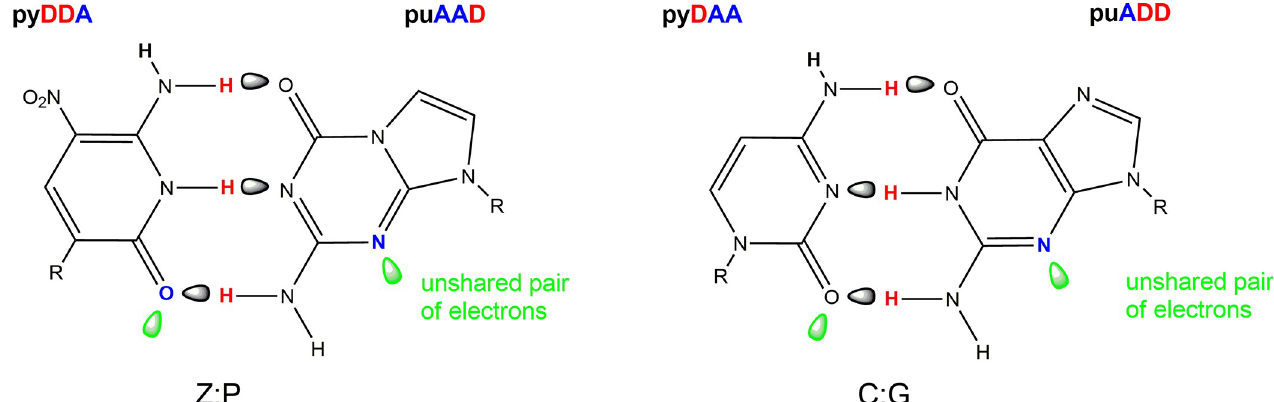
Fig 1. The Z:P pair from an Artificially Expanded Genetic Information System (AEGIS), left. AEGIS nucleotides follow the geometry and hydrogen bonding architecture of the natural nucleotides. The hydrogen bonding patterns are named pu or py, depending on whether they are presented on a large (purine-like) or small (pyrimidine-like) heterocyclic ring system respectively. Hydrogen bond donor (D) and acceptor (A) groups listed starting in the major groove and ending in the minor groove. Unshared pairs of electrons presented to the minor groove are shown in green orbitals. The Z:P pair presents the pyDDA:puAAD hydrogen bonding pattern, while the analog C:G pair presents the pyDAA:puADD. R is deoxyribose.